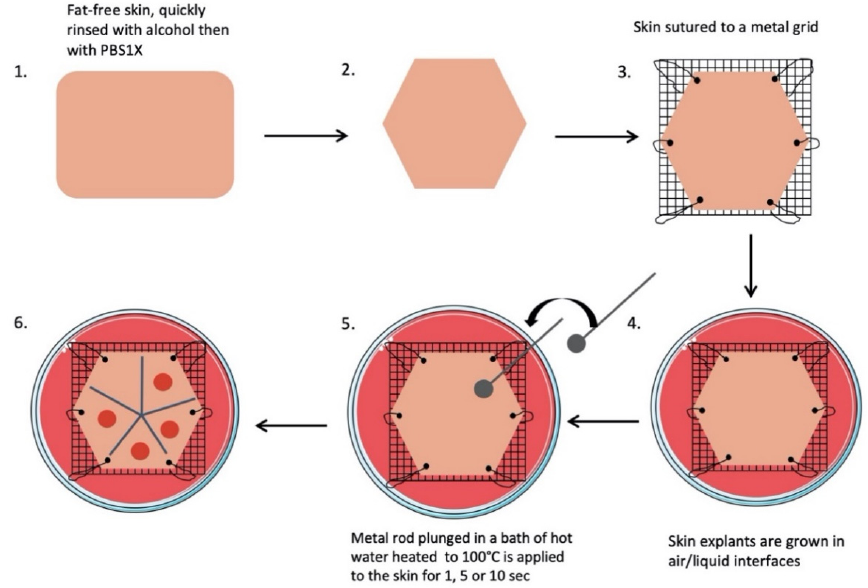
Figure 9. Scheme of the burn procedure on human skin explant model.